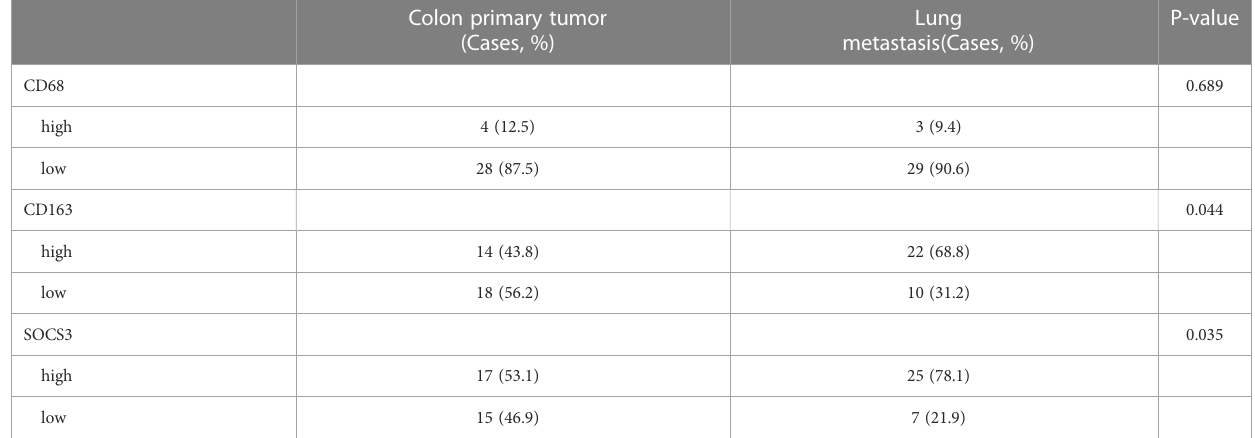
TABLE 3 Comparison of the IHC staining score for CD68, CD163, and SOCS3 between colon primary tumor and lung metastasis. Colon primary tumor (Cases, %)